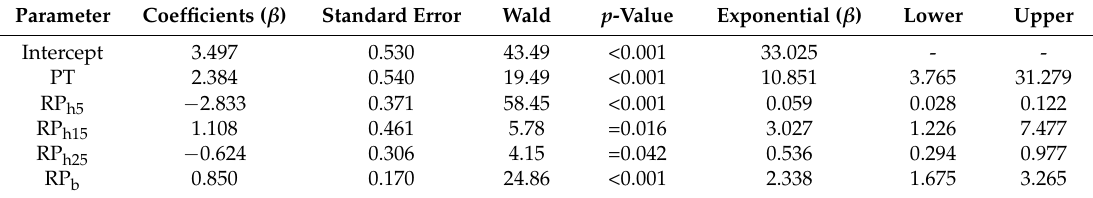
Table 6. Results of survival rate probability modeled by logistic